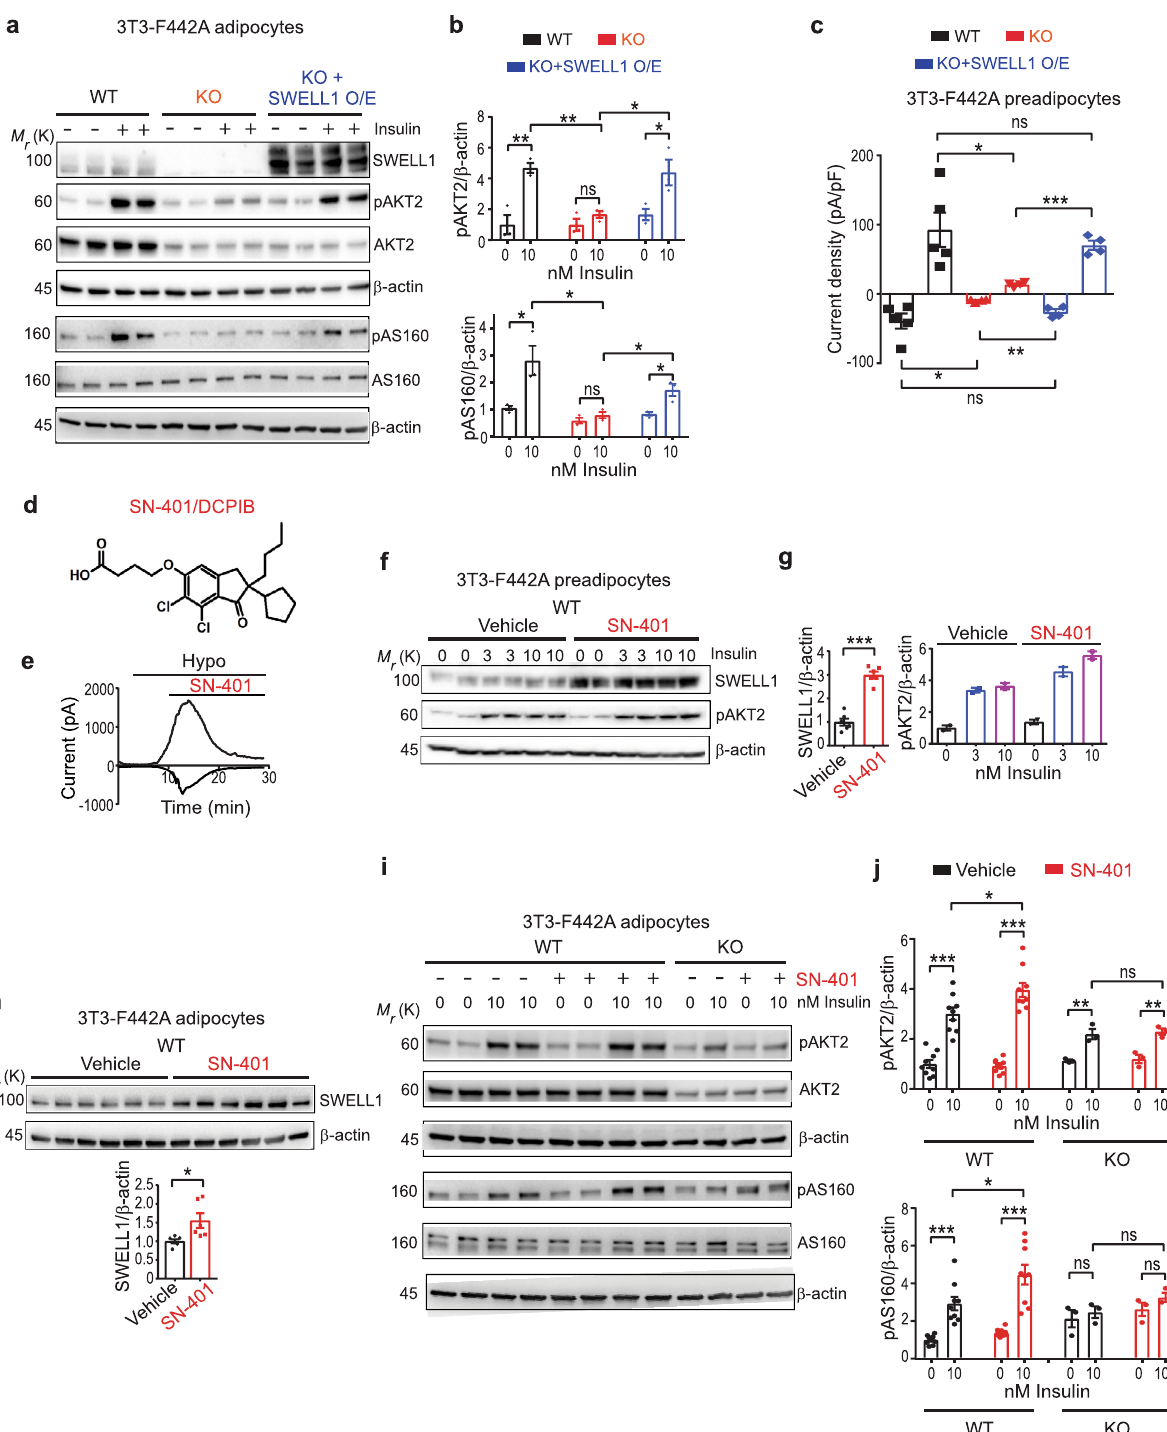
tolerance (Fig. 3d – f). Similarly, lean, non-T2D, glucose-tolerant mice treated with SN-401 have similar FG, GTT and ITT com- pared to vehicle-treated mice (Fig. 3i, j and Supplementary Fig. S4a – c). However, when made insulin-resistant and diabetic after 16 weeks of HFD-feeding, these same mice (from Fig. 3i, j) treated with SN-401 show marked improvements in FG (Fig. 3k), GTT, and ITT (Fig. 3l) as compared to vehicle. These data show that SN-401 restores glucose homeostasis in the setting of T2D, but has little effect on glucose homeostasis in non-T2D mice. Importantly, this portends a low risk for inducing